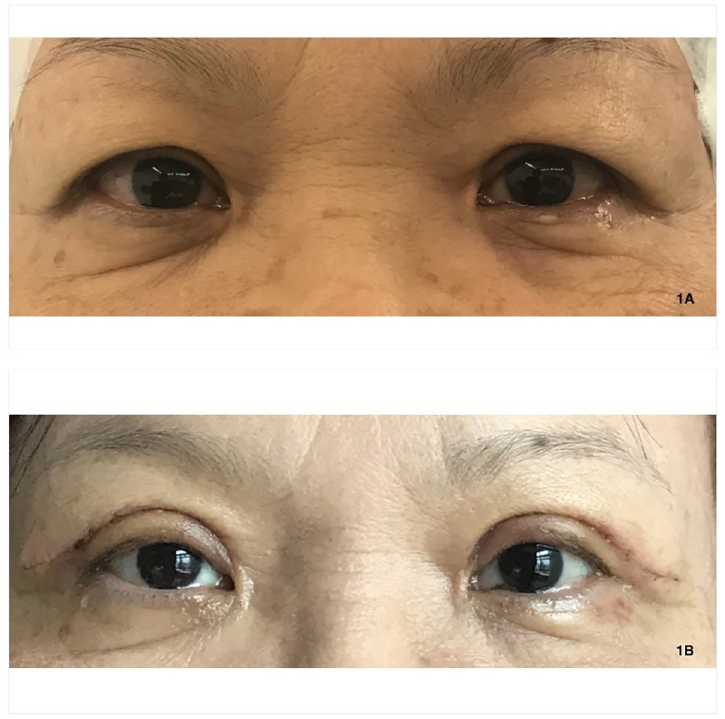
Fig 1. Photo of dermatochalasis patient with lateral hooding. 1A. Before upper eyelid blepharoplasty 1B: One week after upper eyelid blepharoplasty, redundant skin was